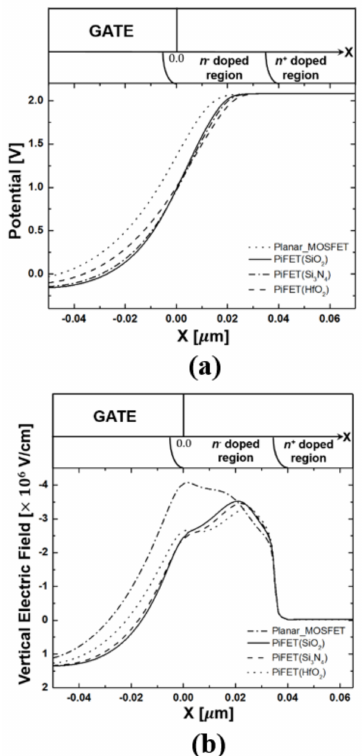
Figure 5. ( a ) Vertical electric field distribution and ( b ) lateral potential distribution on the silicon surface near the drain region for the planar MOSFET and the PiFETs when V GS = − 0.5 V and V DS = 1.6 V.